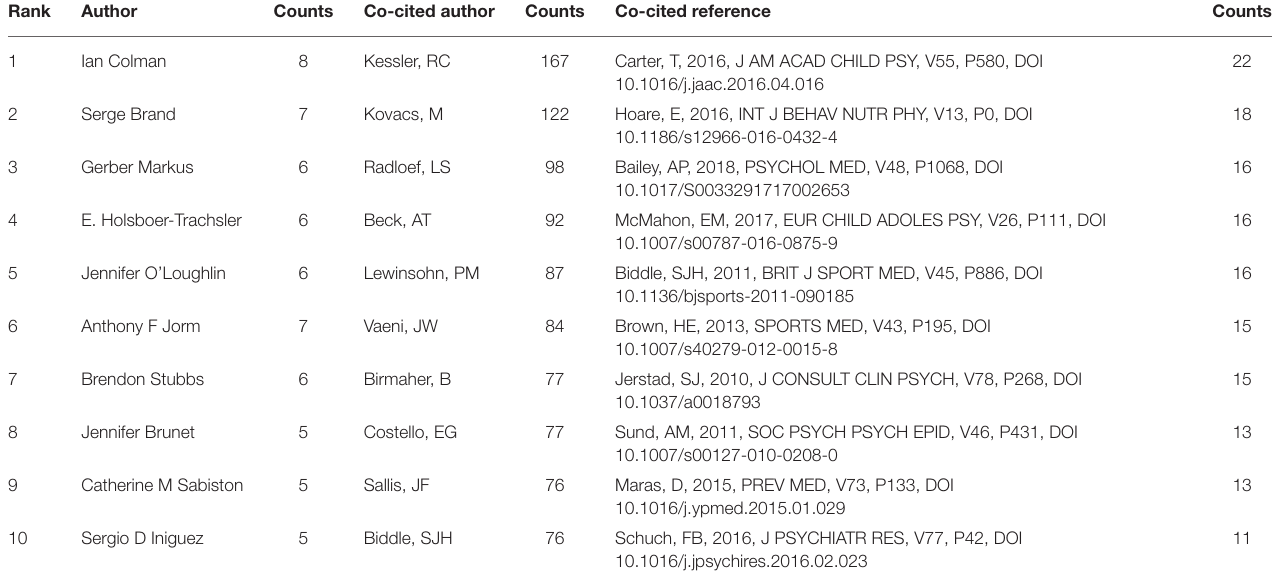
TABLE 3 | Ranking of top 10 authors, co-cited authors, and co-cited references in the field of exercise-depression-teenager research from 2000 to 2020.